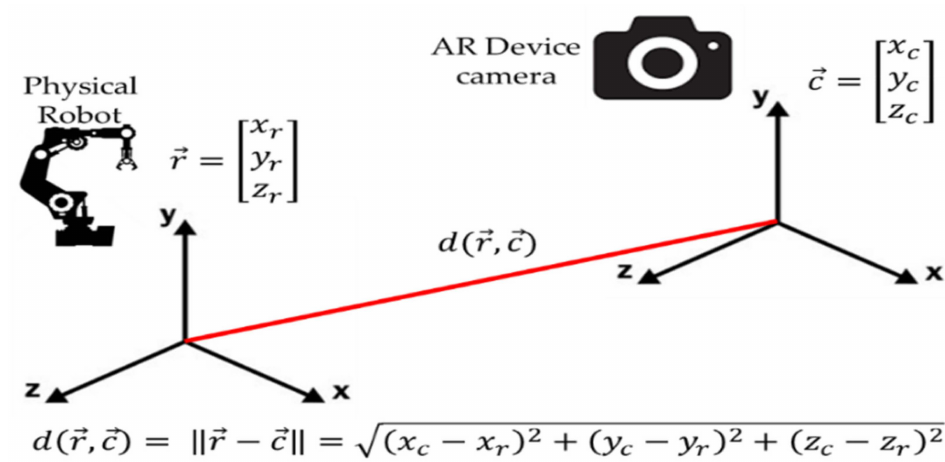
Figure 3. Distance calculation